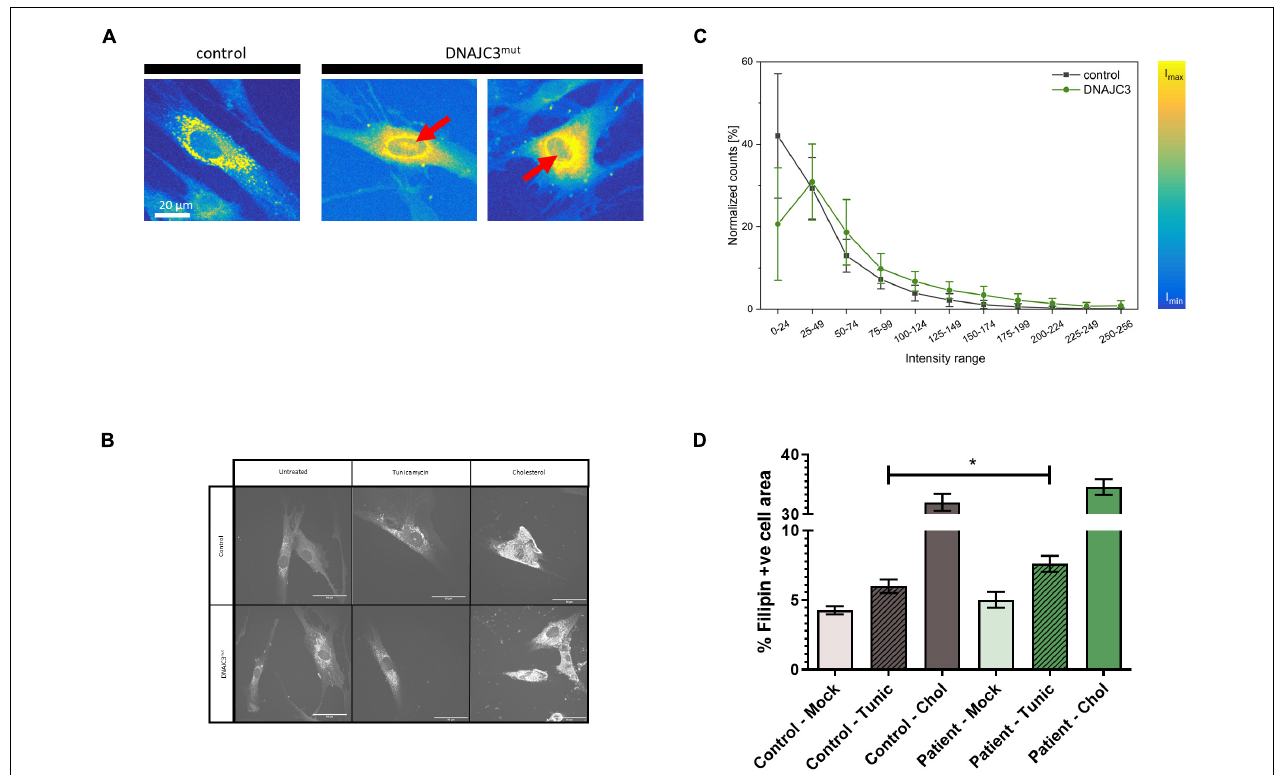
FIGURE 2 | Lipid-level in DNAJC3-pathophysiology. (A) Results of BODIPY staining are shown for one representative fibroblast derived from controls ( left panel ) and two from DNAJC3 patients ( right panel ). Notably, in DNAJC3 mut cells, nuclear accumulated BODIPY staining can be observed (red arrows), which is absent in controls. (B) Single-cell histogram analysis: comparison of intensity histograms for DNAJC3 mut cells (green circles) with control cells (gray squares). Two samples per group were analyzed and at least 10 individual cells were used per sample for statistical analyses. For each cell, a histogram analysis was performed giving the frequency of intensity values in the specified ranges. Counts per intensity range were normalized to percentage values for individual cells before calculating the mean and standard deviation for each group. DNAJC3 mut fibroblasts tend to have more points with high fluorescence intensity than control cells, indicating an increased level of BODIPY stained lipids and thus an agglomeration/accumulation of lipids in these cells. (C) Confocal microscope images of Filipin III staining are shown for one representative fibroblast derived from controls and one DNAJC3 patient in the presence or absence of cholesterol or Tunicamycin. (D) Quantification of mean Filipin III positive area relative to cell area (%) for DNAJC3 mut and control fibroblasts. Both tunicamycin (Tunic) and cholesterol stress (Chol) treatments increase % Filipin positive area relative to control ( p < 0.01, Student’s t -test with Welch’s correction) in both DNAJC3 mut and control, with * indicating statistical significance between DNAJC3 mut and control groups of the same treatment